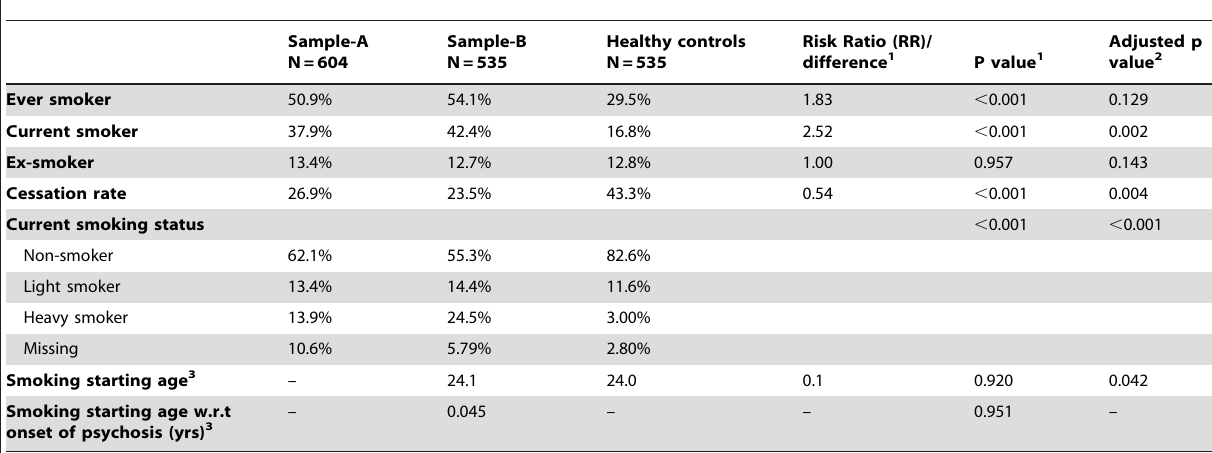
Table 2. Comparison of smoking patterns between schizophrenia male patients and male healthy controls.